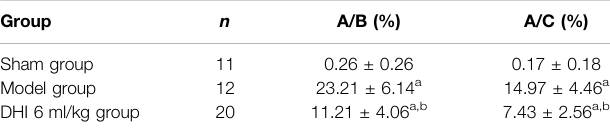
A, myocardial infarction size; B, ventricular size; C, total heart size. a p < 0.01 vs. sham. b p < 0.01 vs.